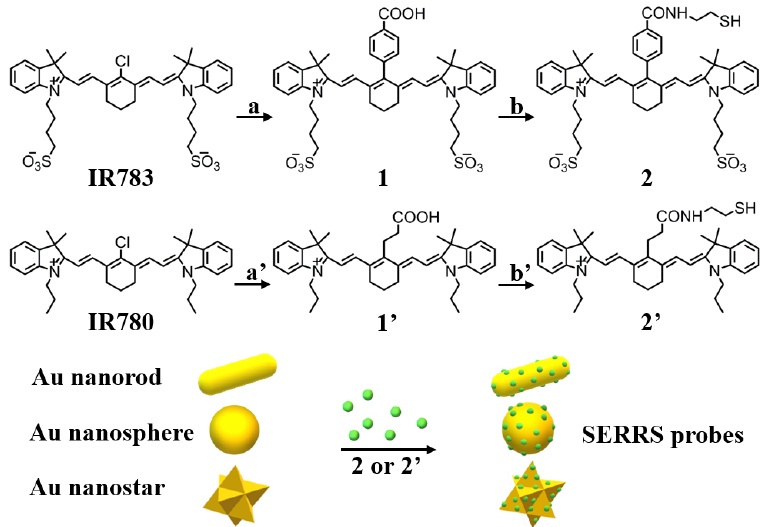
Fig. 2. Synthesis of sulfhydryl moiety functionalized RMs and SERRS nanoprobes. (a): K 2 CO 3 , 4-carboxyphenylboronic acid, Pd[P(Ph) 3 ] 4 ; (b): TEA, EDC, HOBT, (cid:2) -Mercaptoethylamine; (a'): 3-mercapropionic acid, TEA, DMF; (b'): DMF, EDC, HOBT, (cid:2)